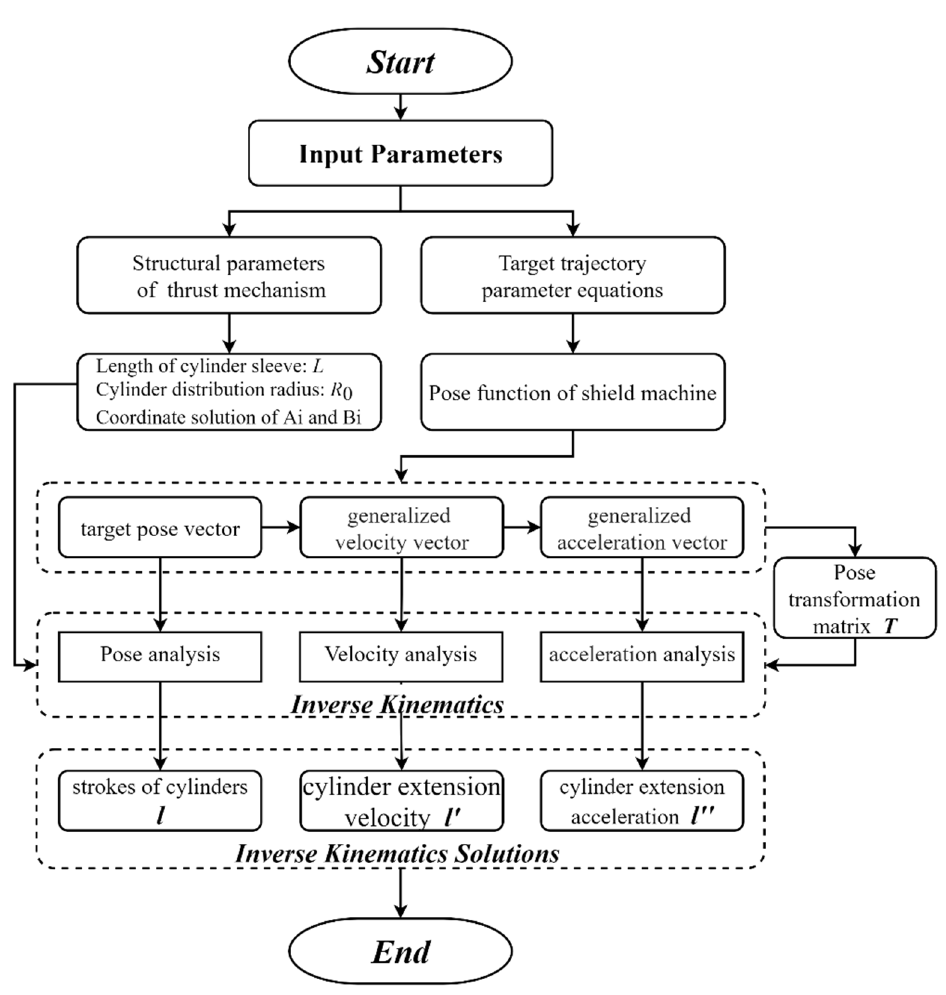
Figure 3. Calculation procedure for the inverse kinematic solutions of the shield thrust system.